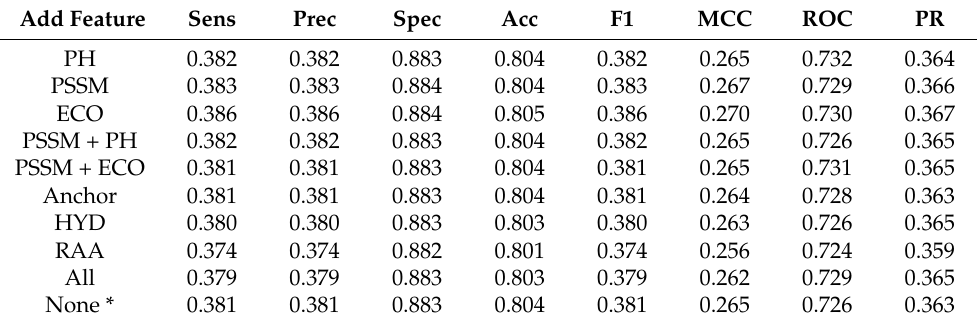
Table 7. Comparison the addition of side features. * The “None” row represents the PITHIA model. Add